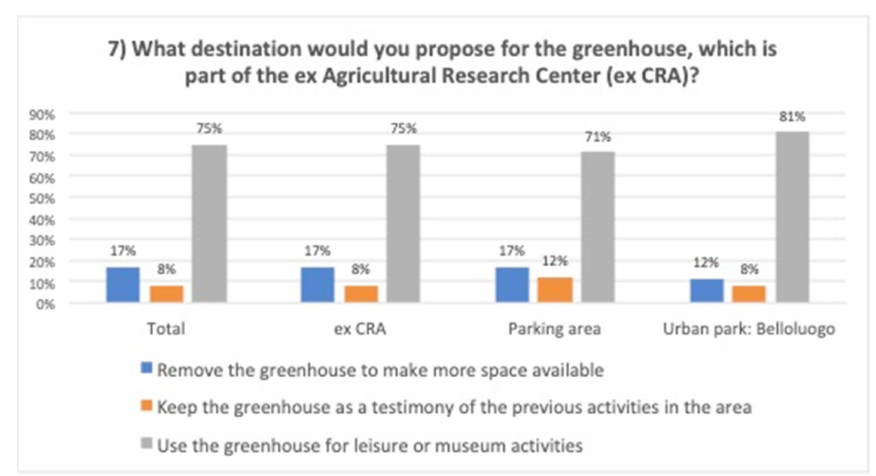
Figure 8. The question related to the